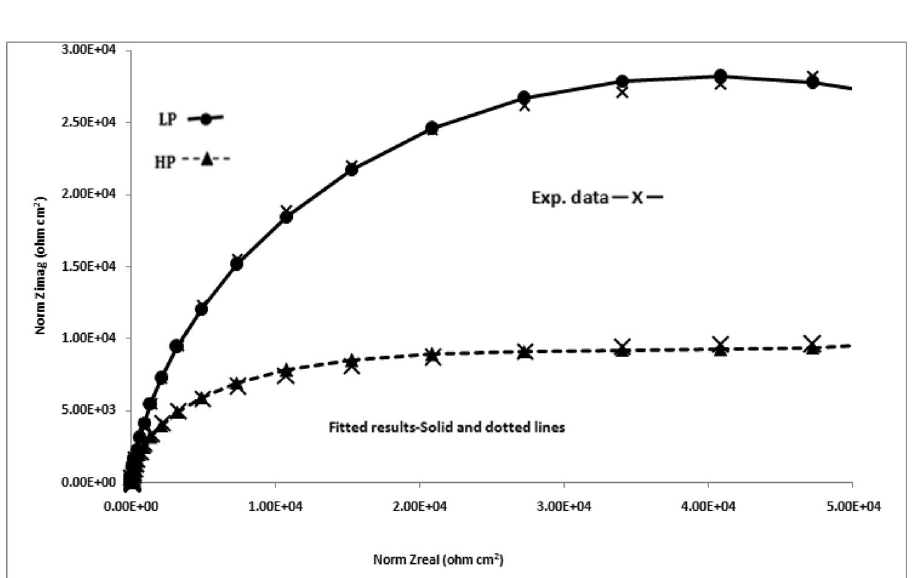
Figure 16. Electrochemical impedance plots in Nyquist form for HP and LP steel bars after 24 h of their exposure in chloride added SPSL.